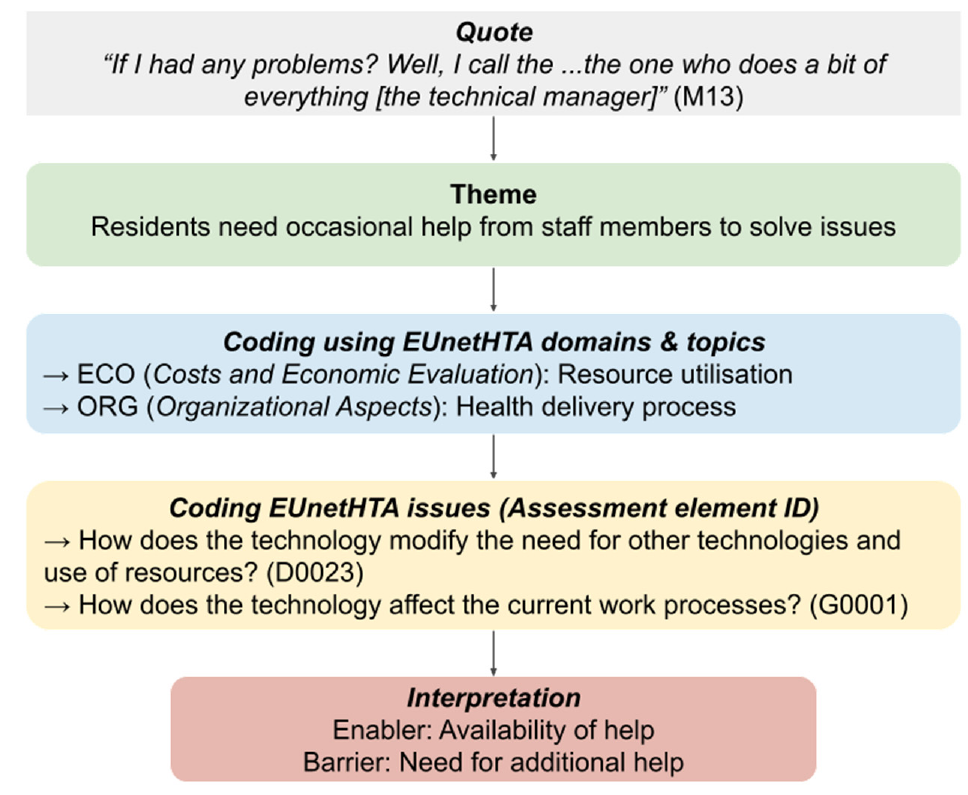
Figure 3. Example of data coding using the EUnetHTA framework.